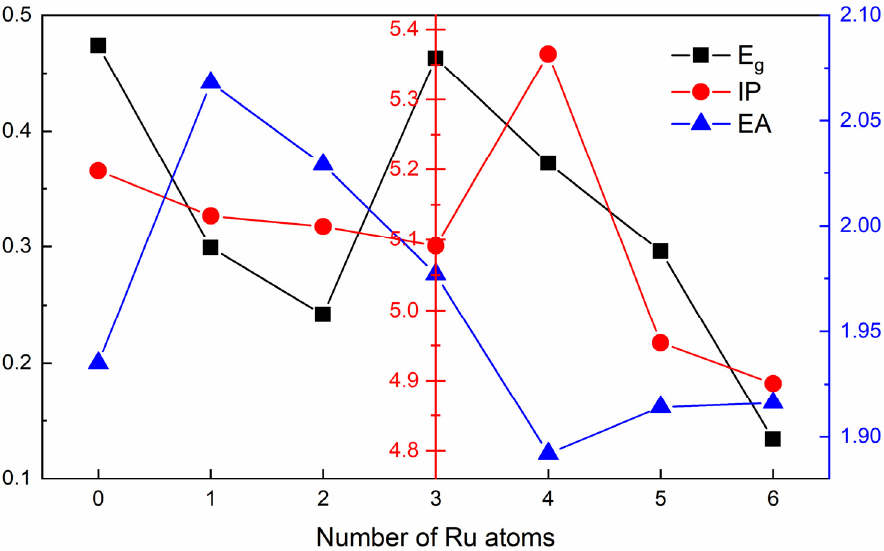
Figure 4. The E g (eV), IP (eV) and EA (eV) for the octahedral Ru m Rh n clusters system varying with the number of Ru atoms. Compared with pure Rh 6 clusters, alloying Ru m Rh n clusters have smaller energy gap and stronger chemical activation. Ru 4 Rh 2 has highest IP and lowest EA in all clusters.